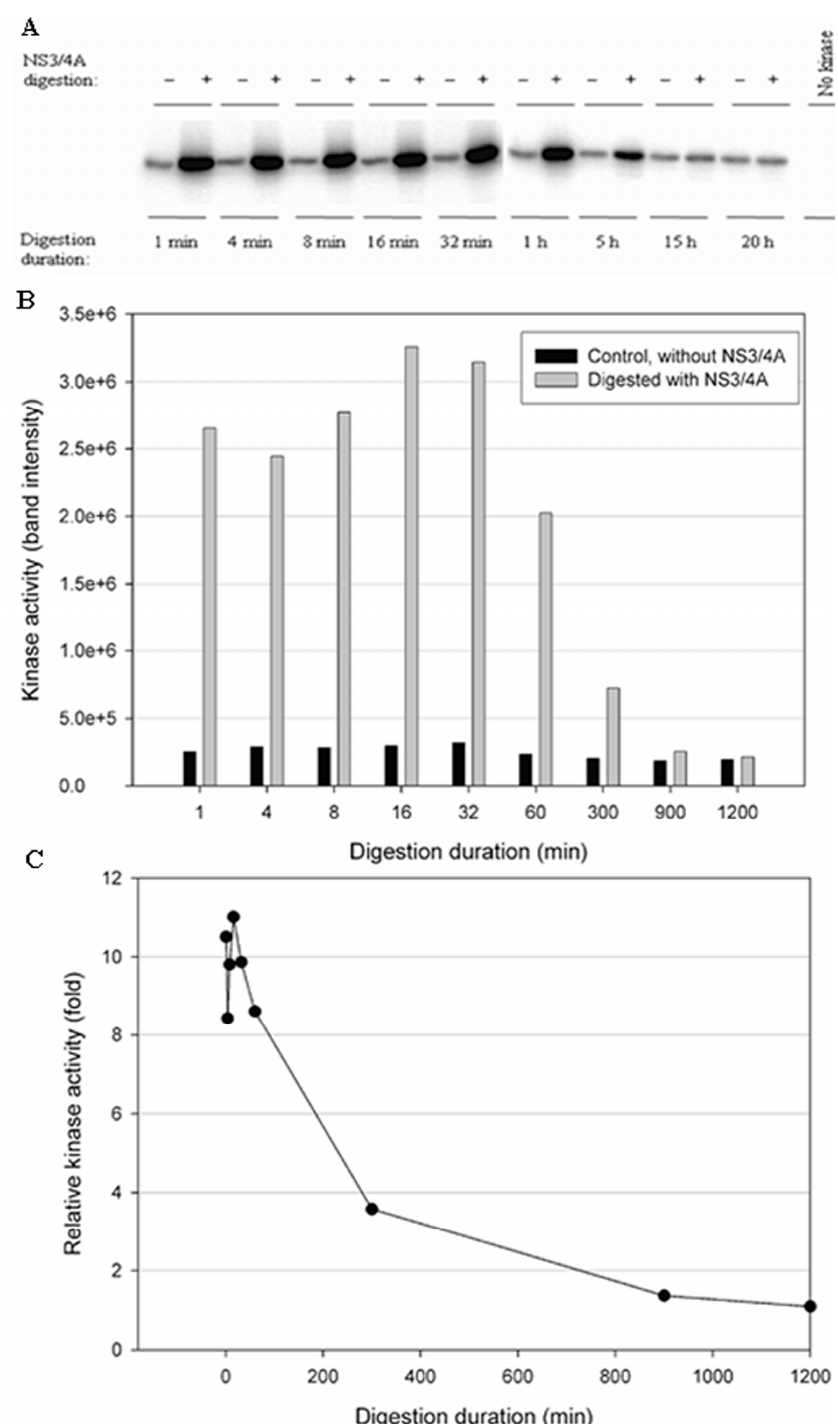
Figure 6. Effect of NS3/NS4A cleavage of IKK ε in a time-dependent manner. The kinases (0.5 μ g) were treated with NS3/NS4A (1.25 μ M NS3 + 325 μ M NS4A). ( A ) IKK ε was treated with or without NS3/4A up to 20 h. The kinase activity was tested using GST-I κ B α (residues 5–55) and [ γ - 32 P] ATP as substrates. Phosphorylated GST-I κ B α bands were detected by a PhosphoImager. ( B ) The band intensities detected by the PhosphoImager were plotted versus time. ( C ) The relative kinase activities (IKK ε treated with NS3/4A versus untreated control) were plotted versus time.